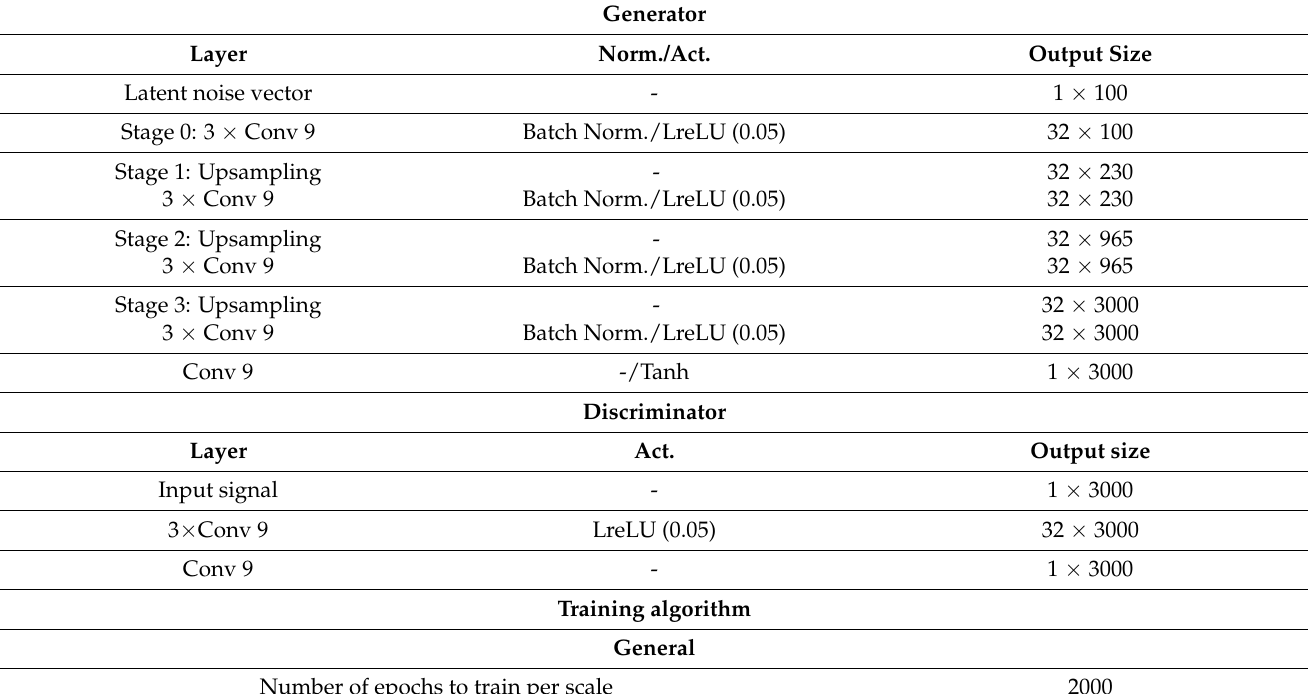
Table 1. Hyperparameters of generator, discriminator, and training